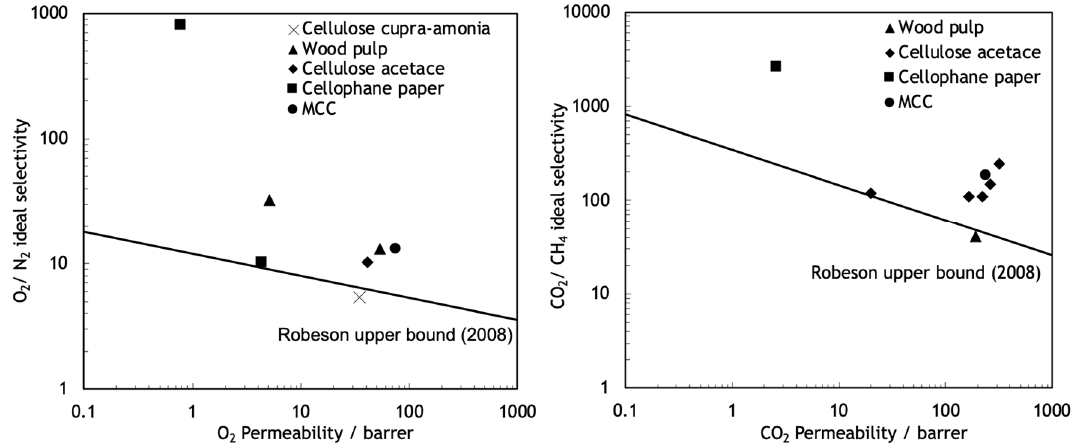
Figure 7. Robeson plot for O 2 /N 2 and CO 2 /CH 4 separation with the best cellulose-based CMSM